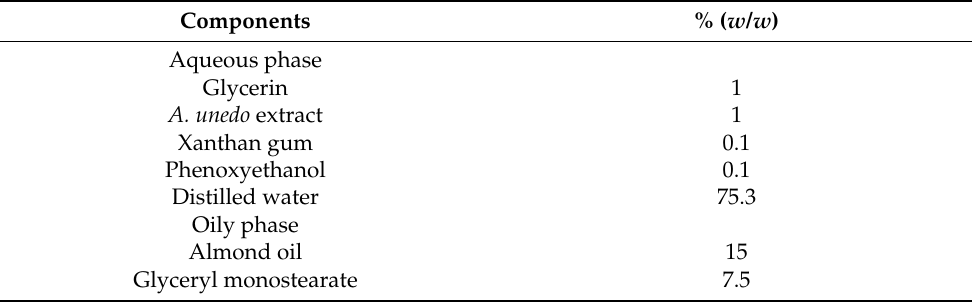
Table 1. Composition of the O/W formulation containing A. unedo phenolic